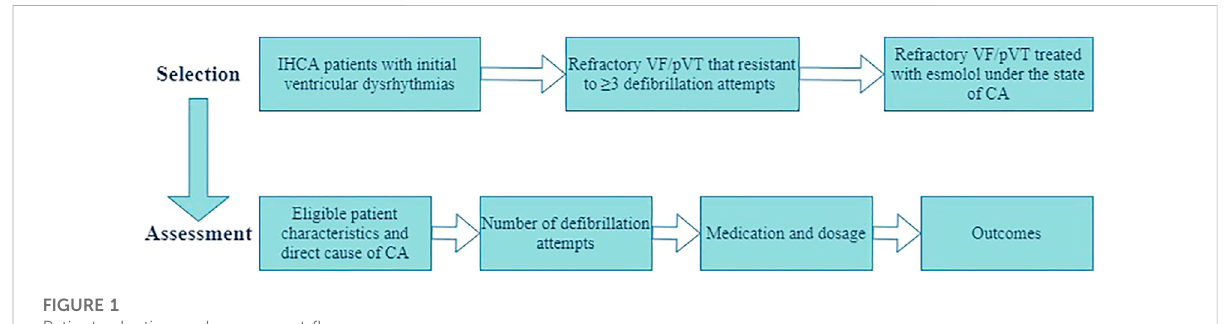
FIGURE 1 Patient selection and assessment fl